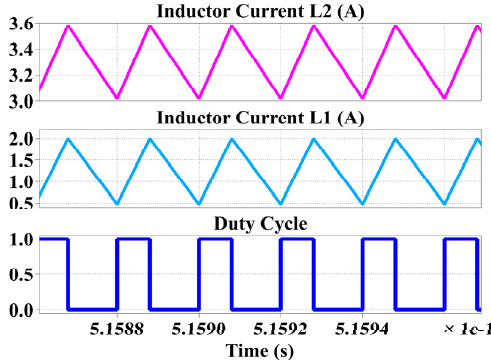
Figure 9. Inductor currents of L 1 and L 2 at D = 0.4.